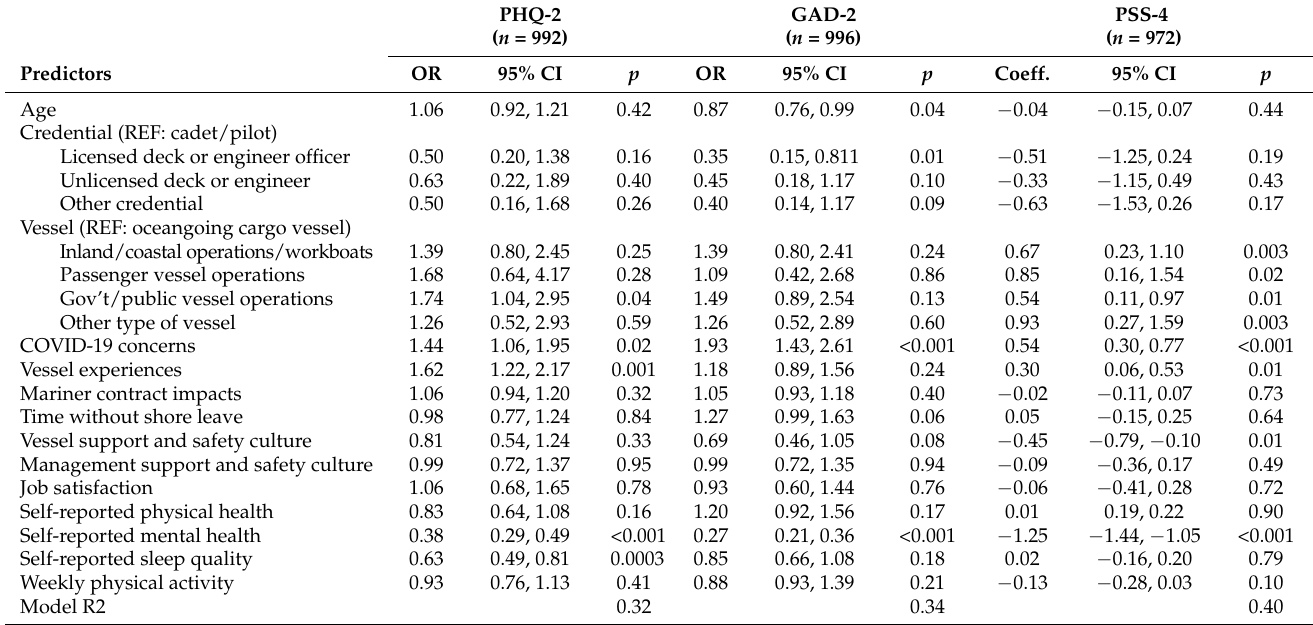
Table 4. Results of logistics and linear regression for outcomes of interest.